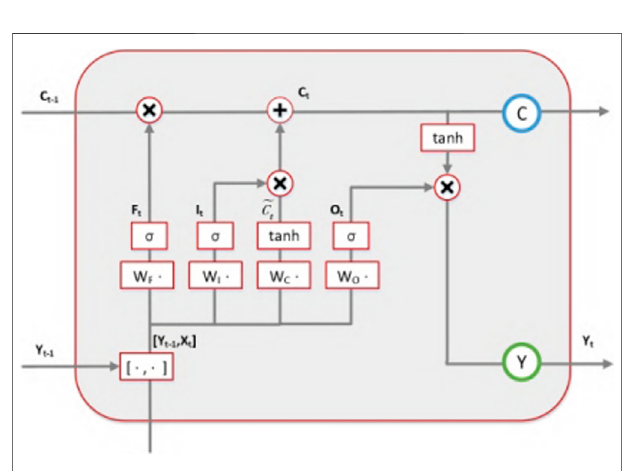
FIGURE 3 | Network structure of LSTM